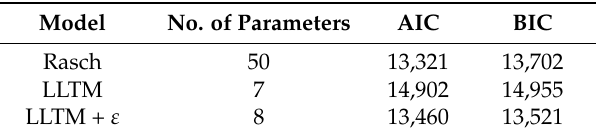
Table 7. Goodness of